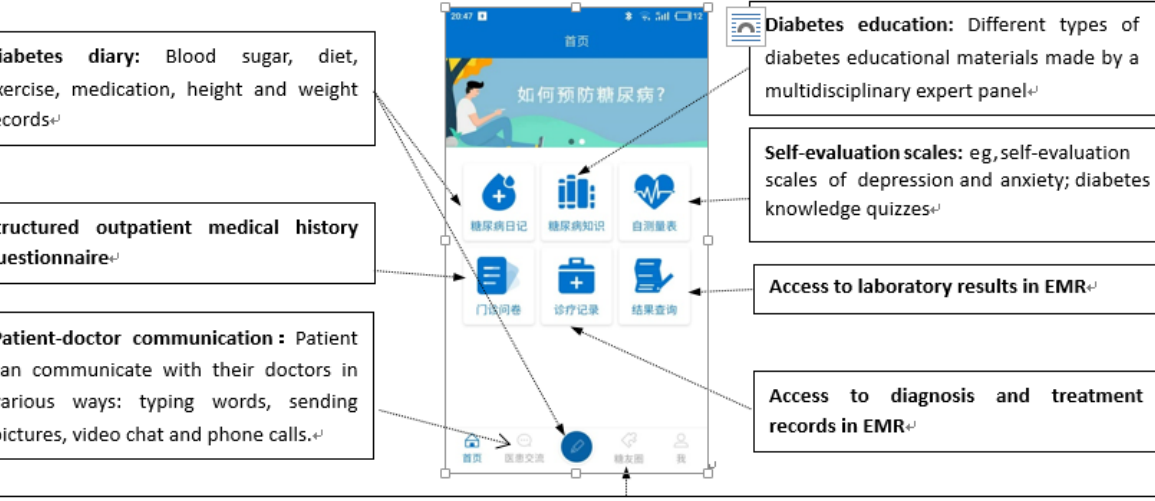
Figure 5. Homepage screenshot of the patient app. EMR: electronic medical